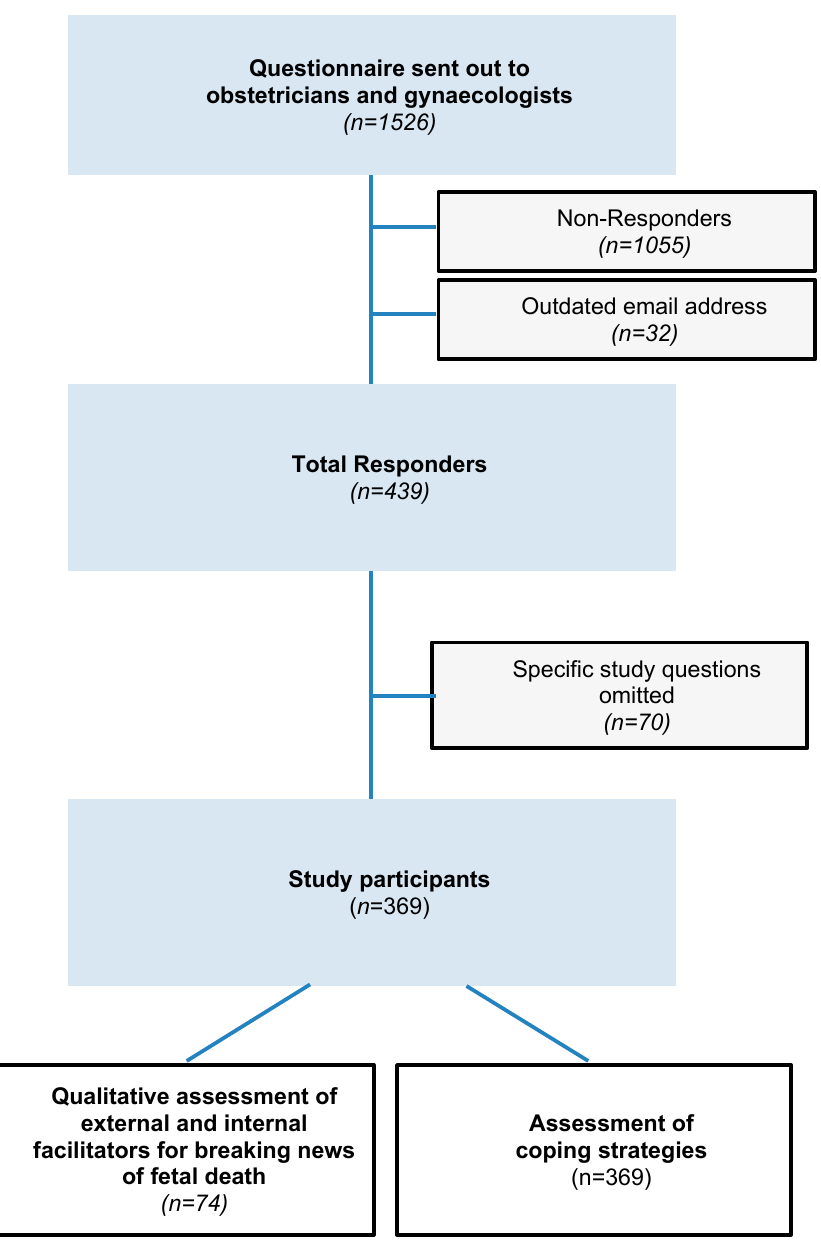
Figure 1. Flowchart illustrating the enrolment of participants ( n = 369) to the survey conducted by the Austrian Society of Obstetrics and Gynecology between 21 September 2020 and 31 October